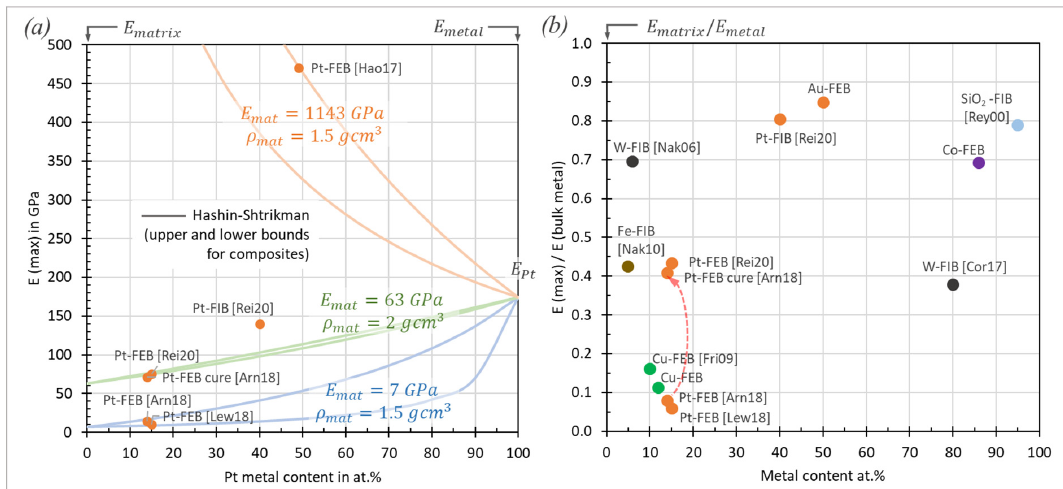
Figure 17. Elastic moduli of FEBID and FIBID material vs. reported metal content. ( a ) For Pt–carbon deposits. Composite elastic moduli according to the Hashin–Shtrikman upper and lower bounds are shown as lines. The corresponding numerical values represent fits to the data points. ( b ) Normalized elastic moduli of metal carbon materials from references indicated in the data legend. Stiffening due to e-beam curing is indicated by an orange dashed arrow. The additional gallium metal content for FIB deposits was not